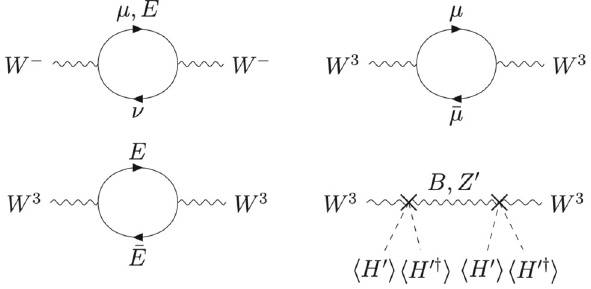
Fig. 2 (Left) (cid:15) a μ as a function of v φ in red line, in comparison to 1 σ (2 σ ) bands for the deviation of the muon g − 2 in yellow(green). We chose m Z (cid:2) = 500GeV and sin β = 0 . 18. (Right) Parameter space in m Z (cid:2) versus g Z (cid:2) for explaining the muon g − 2 within 1 σ (2 σ ), shown between black(blue) lines. For both plots, we fixed M E = 1000GeV and the mixing angles of the vector-like lepton to sin θ L = 0 . 010 and sin θ R = 0 . 011